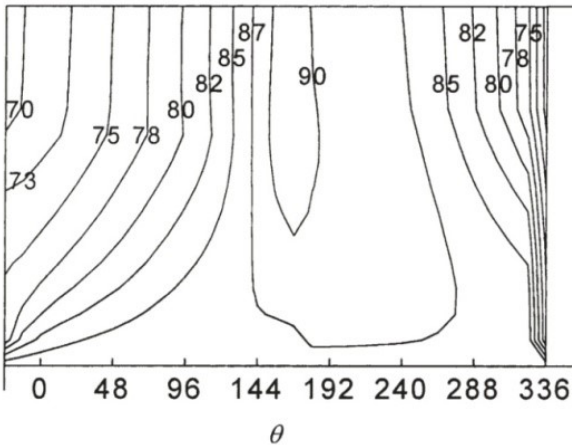
Fig. 4: Maximum temperature versus eccentricity ratio for different values of the couple stress parameter with roughness parameter 0.1